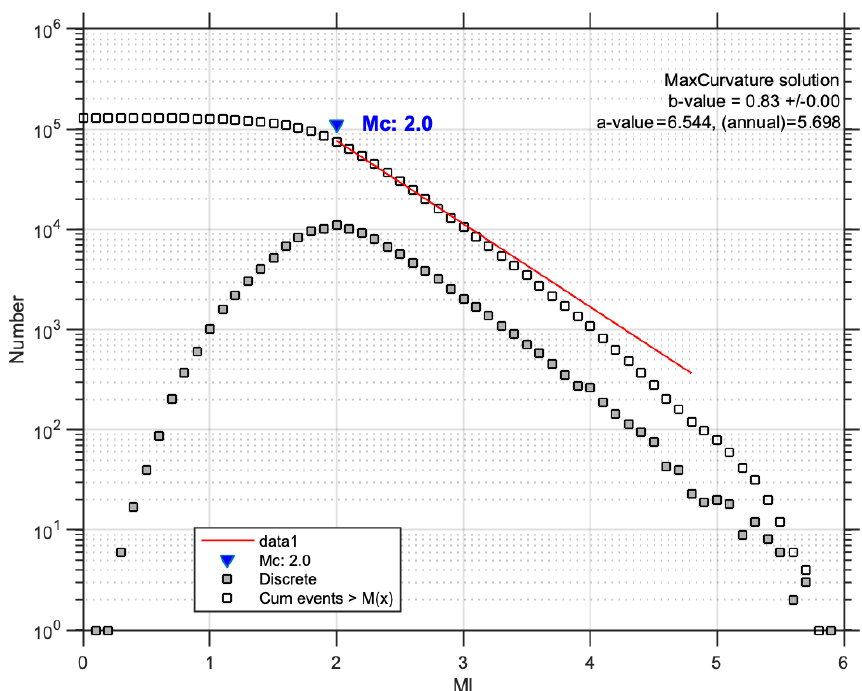
Figure 8. Frequency-magnitude distribution of the catalog in between the time interval 1 January 2012–31 December 2018 with magnitude of completeness M c = 2.0.